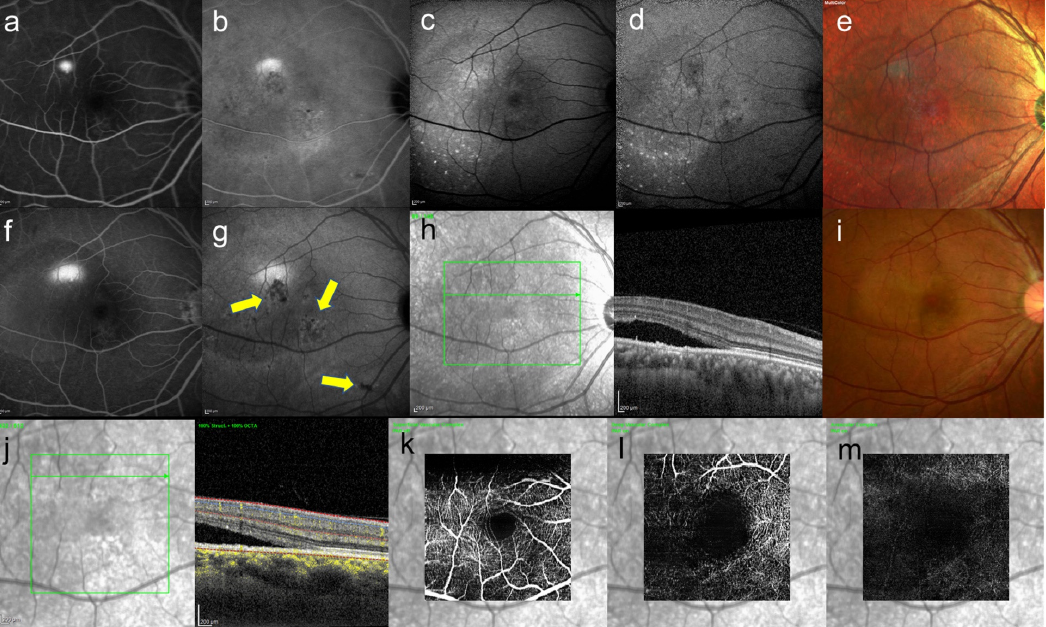
Figure 6. 39-year-old man with unilateral CSC. These images are images of CSC. This patient came to the hospital because of difficulty in vision of his right eye from a month ago. The symptoms disappeared spontaneously four months after the first visit, but recurred five months later. ( a ) FA image acquired at 4 min, smokestack pattern leakage can be seen and ( b ) ICGA image acquired at 12 min, leakage and hypofluorescent area can be seen ( c ) short-wavelength fundus autofluorescence image, ( d ) near-infrared autofluorescence image, partial hyper- and hypofluorescent area can be seen, ( c , d ) discrete small dots with hyperautofluorescence can be seen, ( e ) multi-color fundus photograph, the color tone of the leaking area is different from others, ( f ) FA image acquired at 18 min, smokestack pattern leakage enlarged and ( g ) ICGA image acquired at 26 min, abnormal hypofluorescence can be seen (arrows) ( h ) infrared + OCT (horizontal section) through the serous retinal detachment, ( i ) color fundus photograph, serous retinal detachment with fibrinous contents were observed, ( j ) infrared + OCT angiography (horizontal section) through the serous retinal detachment, ( k ) superficial vascular seg- ment OCT angiography, ( l ) deep vascular segment OCT angiography, ( m ) avascular segment OCT angiography, ( k , l ) there is no macular neovascularization.